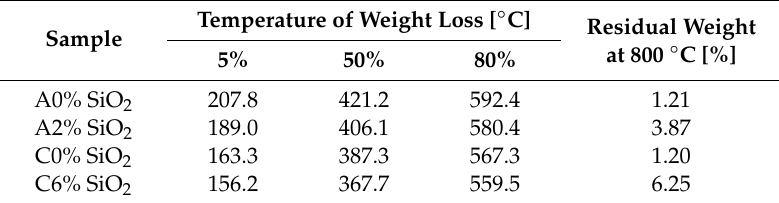
Table 5. Thermal stability of the studied PURs.